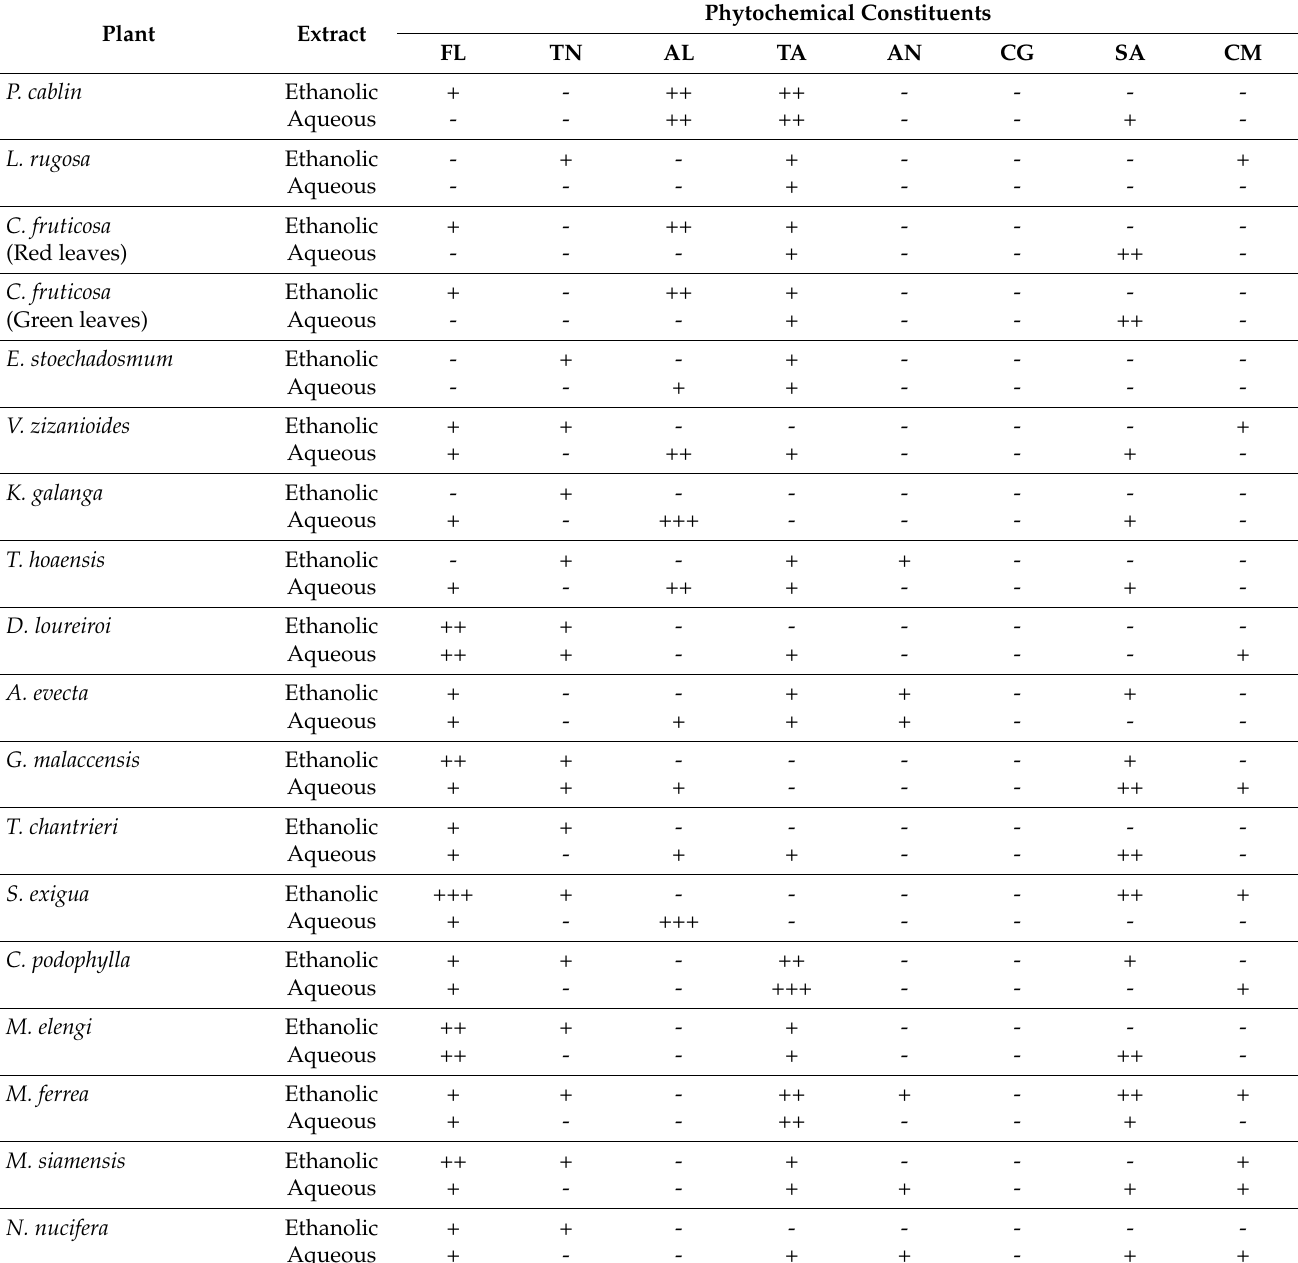
Table 3. Phytochemical screening of ethanolic and aqueous extracts of the medicinal plants in the Kheaw Hom